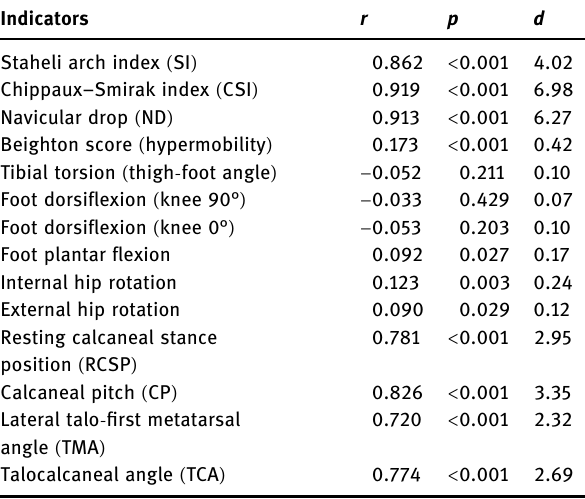
Table 4: Study indicators and FPI: correlations and e ff ect